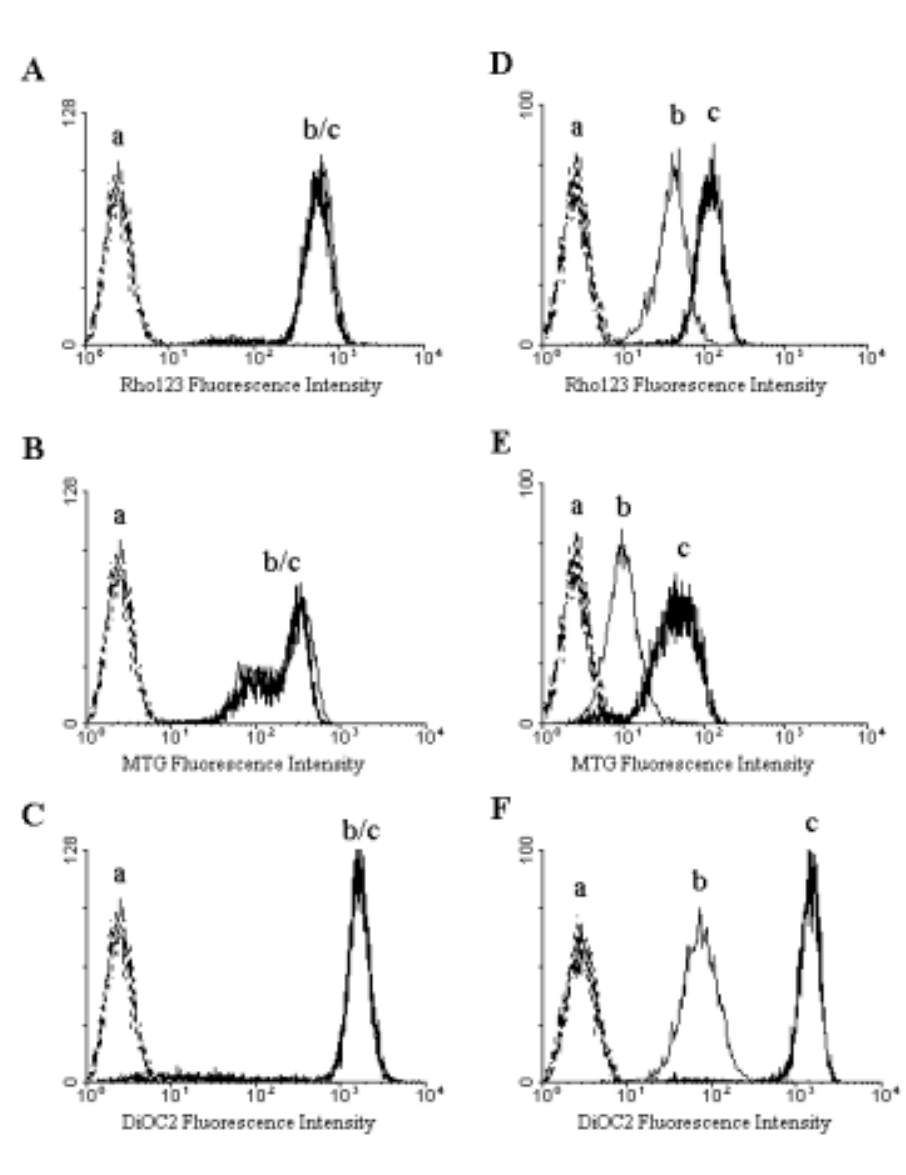
Fig. 2 – Rhodamine 123, Mitotracker Green and DiOC 2 are P-Glycoprotein Substrates. K562 ( A , B and C ) and Lucena 1 cell lines ( D , E and F ) were incubated in the presence of Rho 123 (200 ng/ml – A and D ), MTG (50nM – B and E ) or DiOC 2 (60 ng/ml – C and F ) for 30 minutes. After this period, cells were washed with cold saline and analysed in a Flow Cytometer. Co-incubation with cyclosporinA (CSA 200 ng/ml) increase Rho 123 ( D ), MTG ( E ) and DiOC 2 ( F ) fluorescence in Lucena 1 cells. The same results were obtained when cells were incubated in the presence of trifluoperazyne (TFP 5 µ M) or verapamil (VP 5 µ M) instead of CSA. a – autofluorescence; b – fluorochrome; c – fluorochrome plus CSA. Data are representative of at least 5